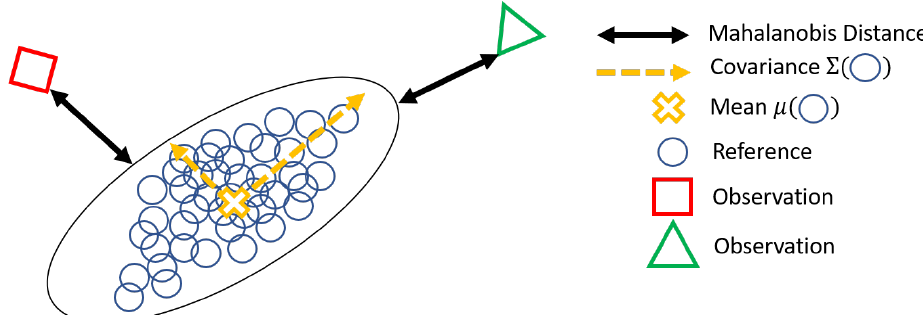
Figure 4. Diagram of the Mahalanobis